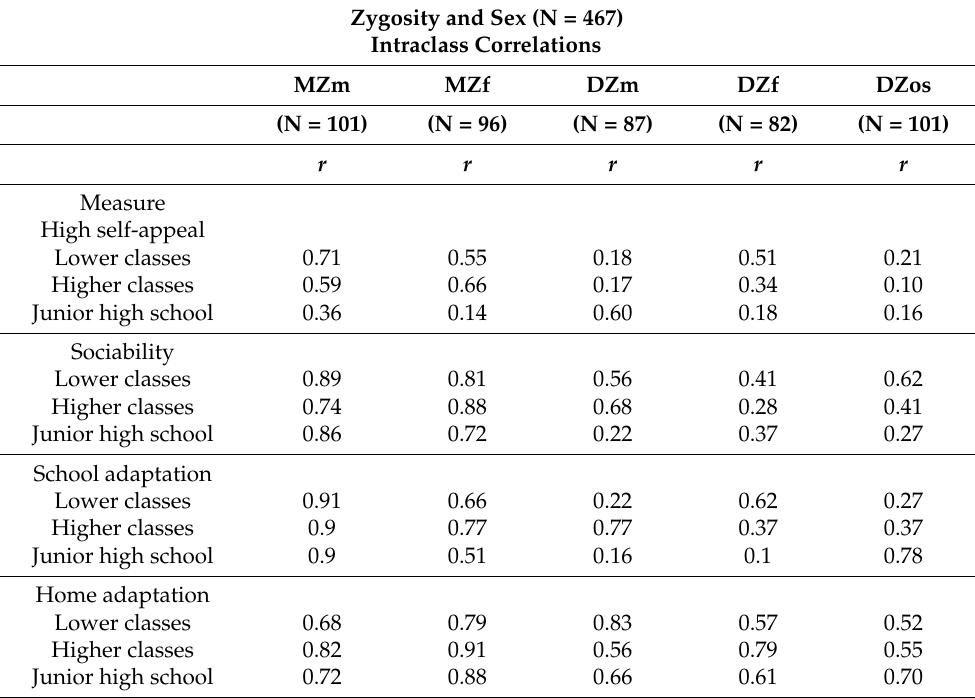
Table 3. Intraclass correlations of four measures for twins by zygosity and sex (group